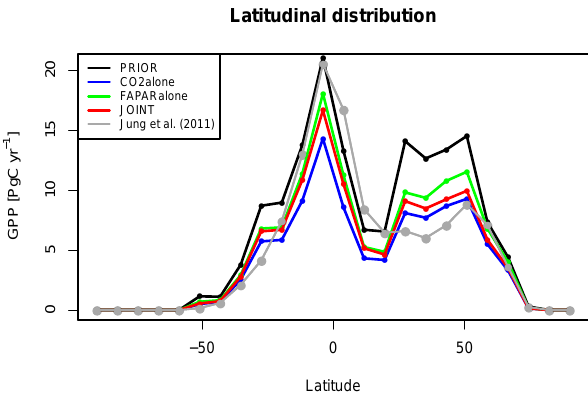
Figure 7. Latitudinal distribution of GPP for the prior and posterior models compared to the independent estimates of Jung et al.